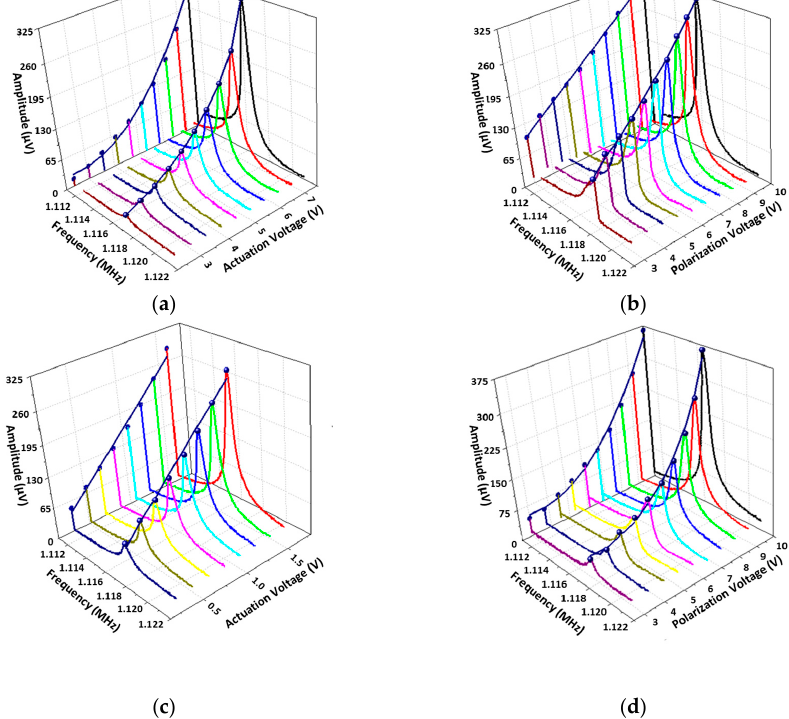
Figure 7. Electromechanical response when the frequency is swept around the resonance for different actuation schemes: ( a ) Amplitude versus f and V AC for a semitone actuation ( V B = 10 V ) ; ( b ) Amplitude versus f and V B for a semitone actuation ( V AC = 6.5 V ) ; ( c ) Amplitude versus f and V AC for a 2 f -actuation ( V B = 10 V ) ; ( d ) Amplitude versus f and V B for a 2 f -actuation ( V AC = 1.8 V ) The main electromechanical features for the torsional mode ( (cid:1858) (cid:2868) ,(cid:1843) and (cid:1848) (cid:3042)(cid:3048)(cid:3047) , the maximum output voltage corresponding to the onset of nonlinearity of the deflection angle (cid:2016) (cid:3030) ) were measured on every pixel of a 96 × 96 array with the 2f ‐ actuation scheme: